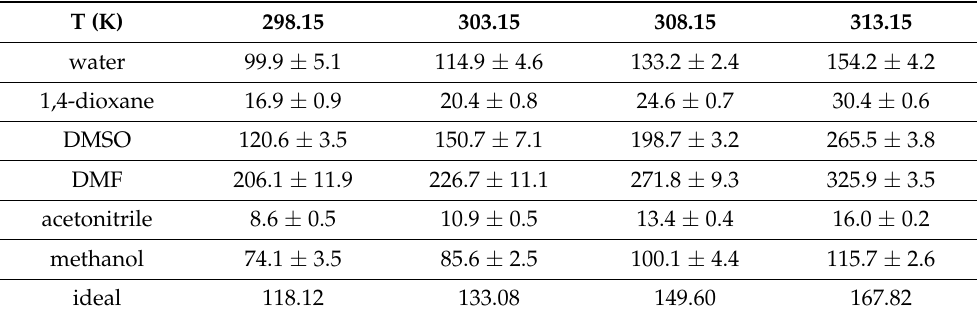
Table 2. Measured values of nicotinamide mole fraction (10 3 ) in saturated solution of neat solvents. Ideal solubility was estimated using Equation (1) and DSC data provided